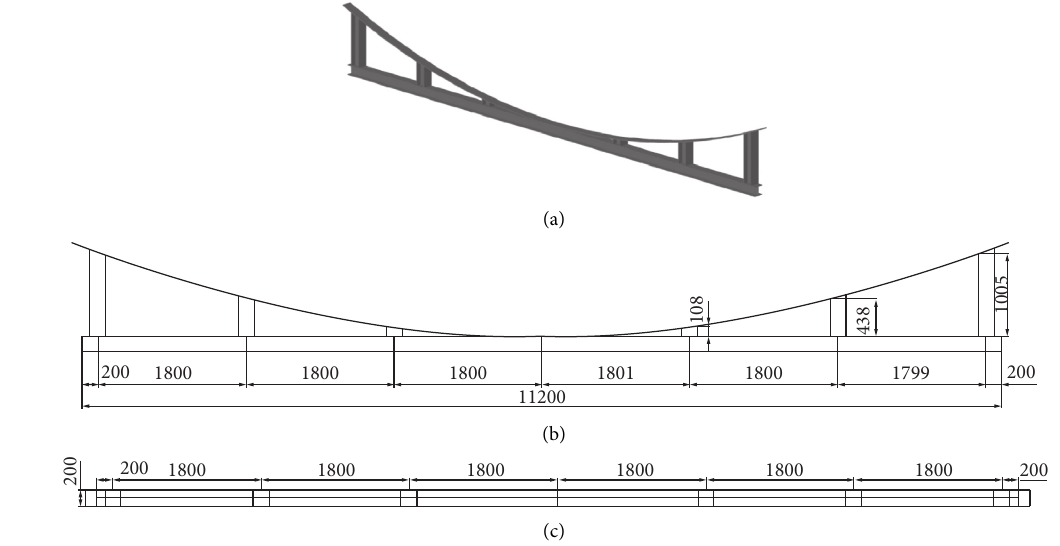
Figure 11: Assembly jig A: (a) 3D model; (b) side view; (c) top view.